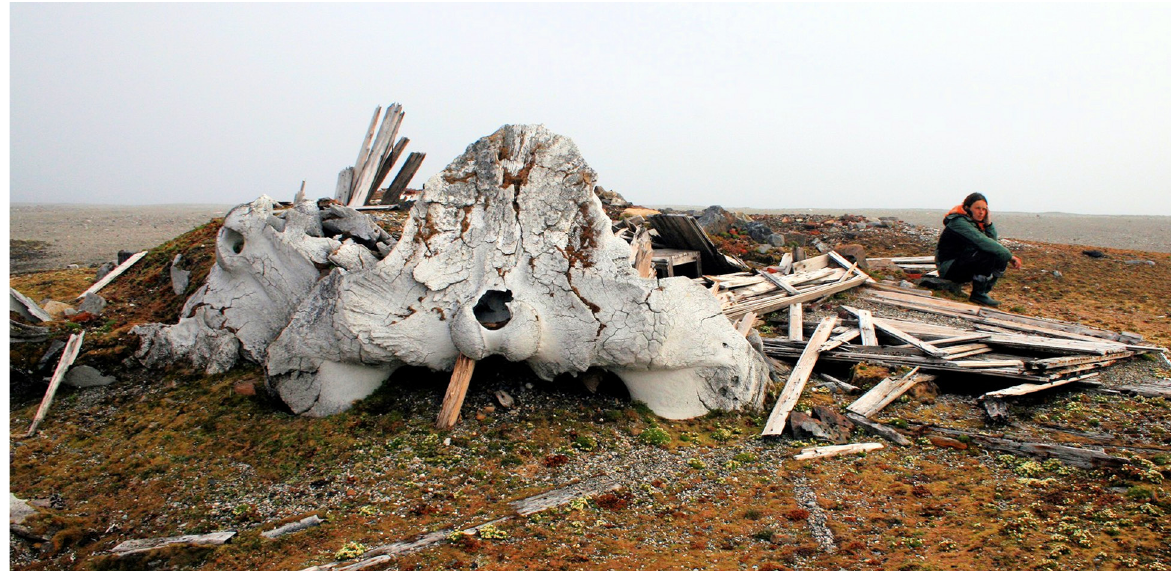
Fig. 1. Whale bones from the 17 th century on the Gåshamna bay, Sør-Spitsbergen National Park (Photo: j.Niedźwiecki 2008).